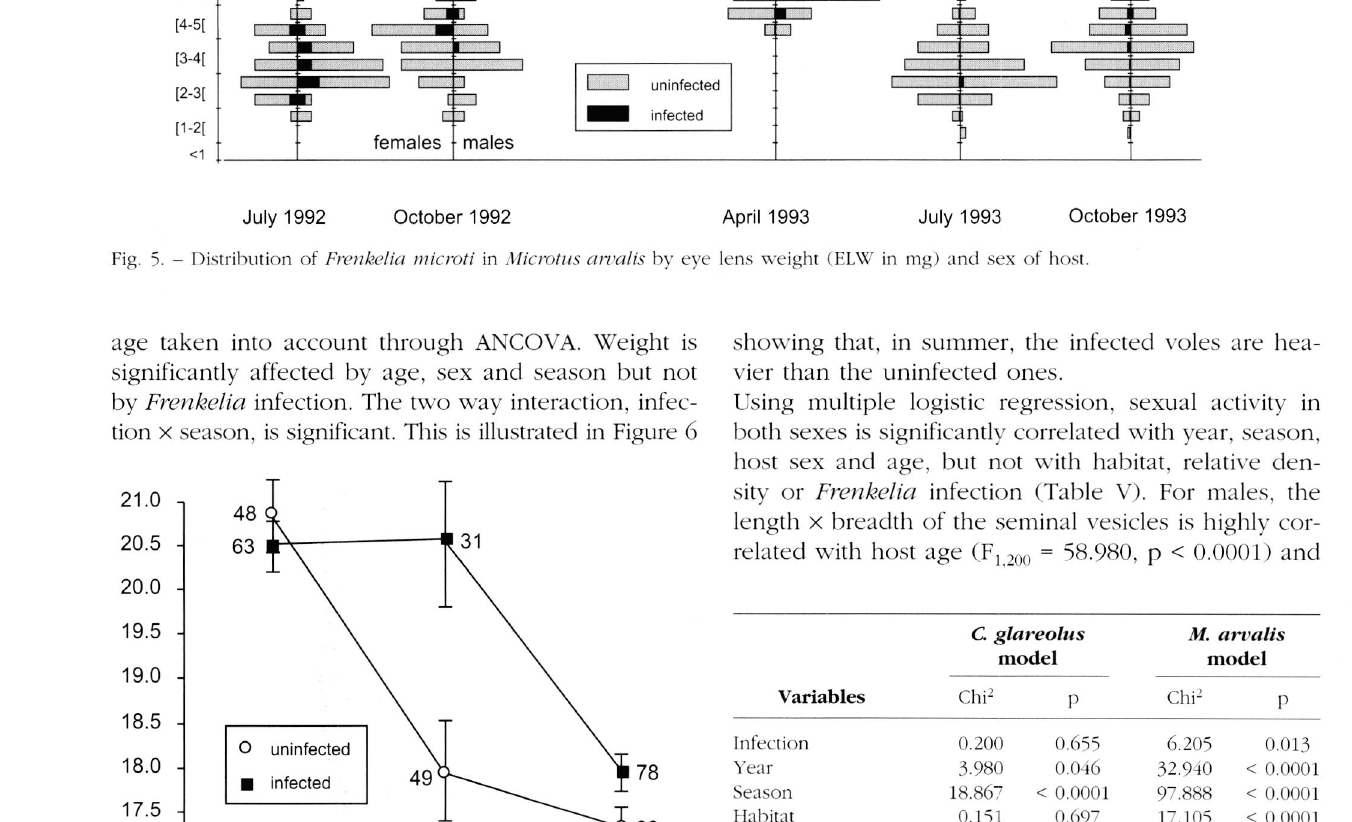
Fig. 6. - Mean body weight (in g with standard error bars) in infected and uninfected C/ethrionomys glareolus, by season. Number close to each symbol indicates the sample size.